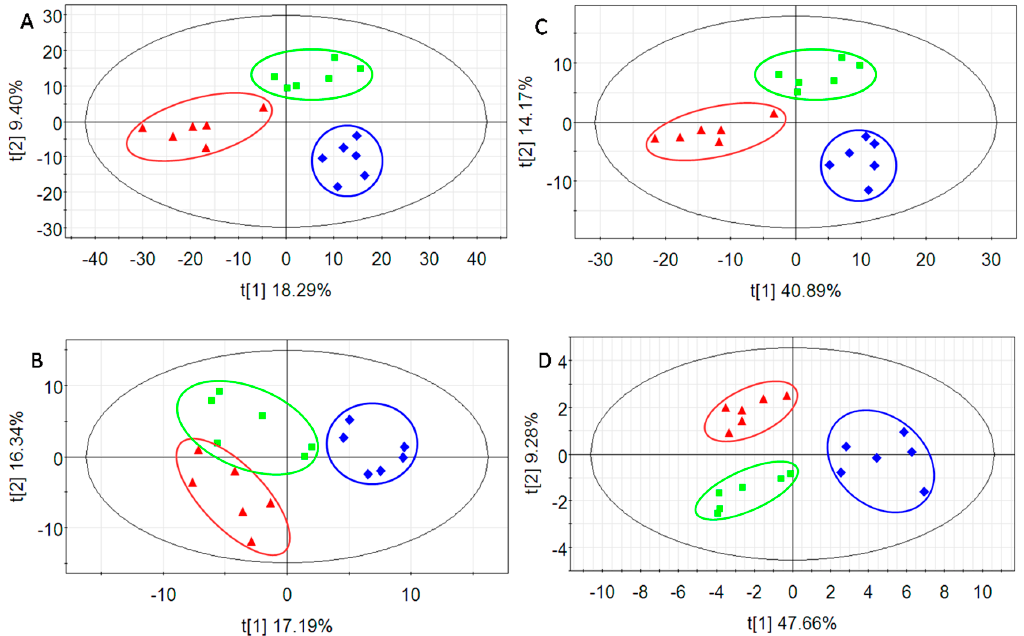
Figure 3. The score plot ( t 1/ t 2) of PLS-DA before ( A , B ) and after ( C , D ) ANOVA: ( A ) positive, R 2 X = 0.375, R 2 Y = 0.936, Q 2 Y = 0.579; ( B ) negative, R 2 X = 0.431, R 2 Y = 0.908, Q 2 Y = 0.617; ( C ) positive, R 2 X = 0.684, R 2 Y = 0.991, Q 2 Y = 0.843; and ( D ) negative, R 2 X = 0.569, R 2 Y = 0.831, Q 2 Y = 0.735. Blue diamond: vehicle control group; Red triangle: model group; Green box: treatment group. Table 2. The comparison of PLS-DA results.